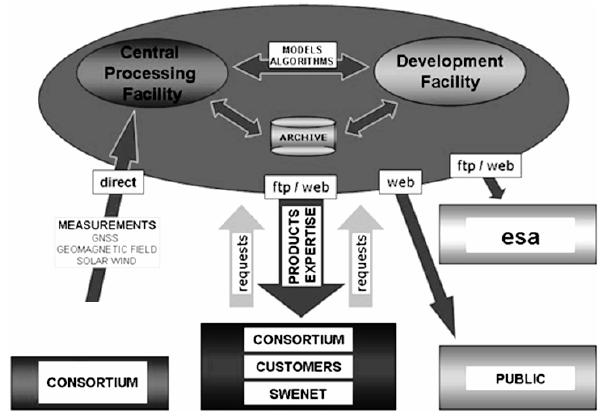
Fig. 5. A schematic view of the SWIPPA operational